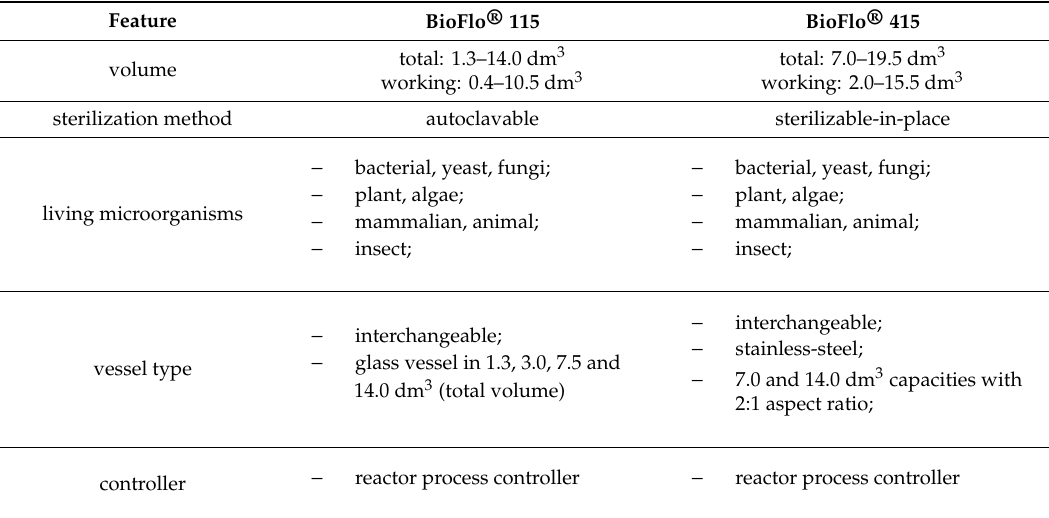
Table 3. Comparison of BioFlo ® 115 and BioFlo ® 415